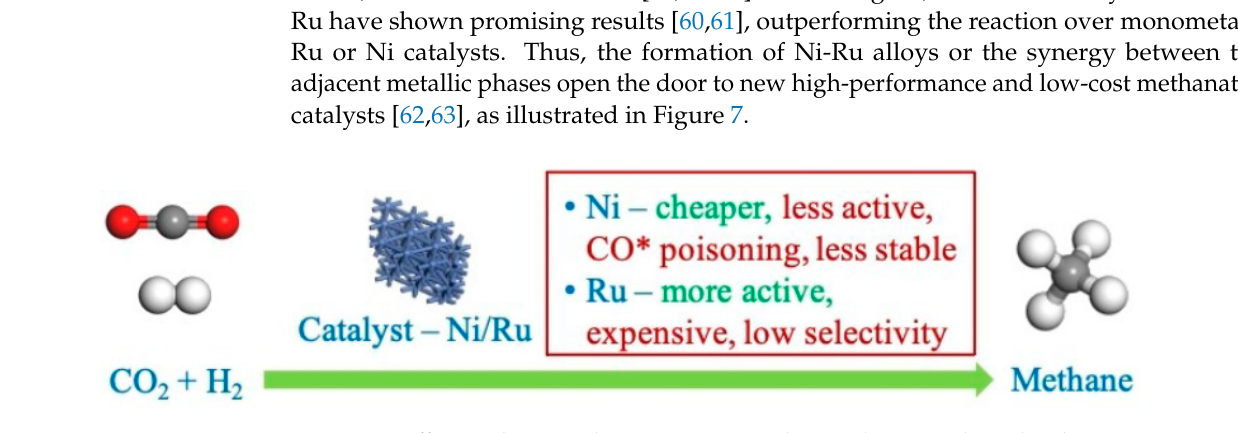
Figure 6. Main parameters influencing the catalyst design to improve the catalytic performance of